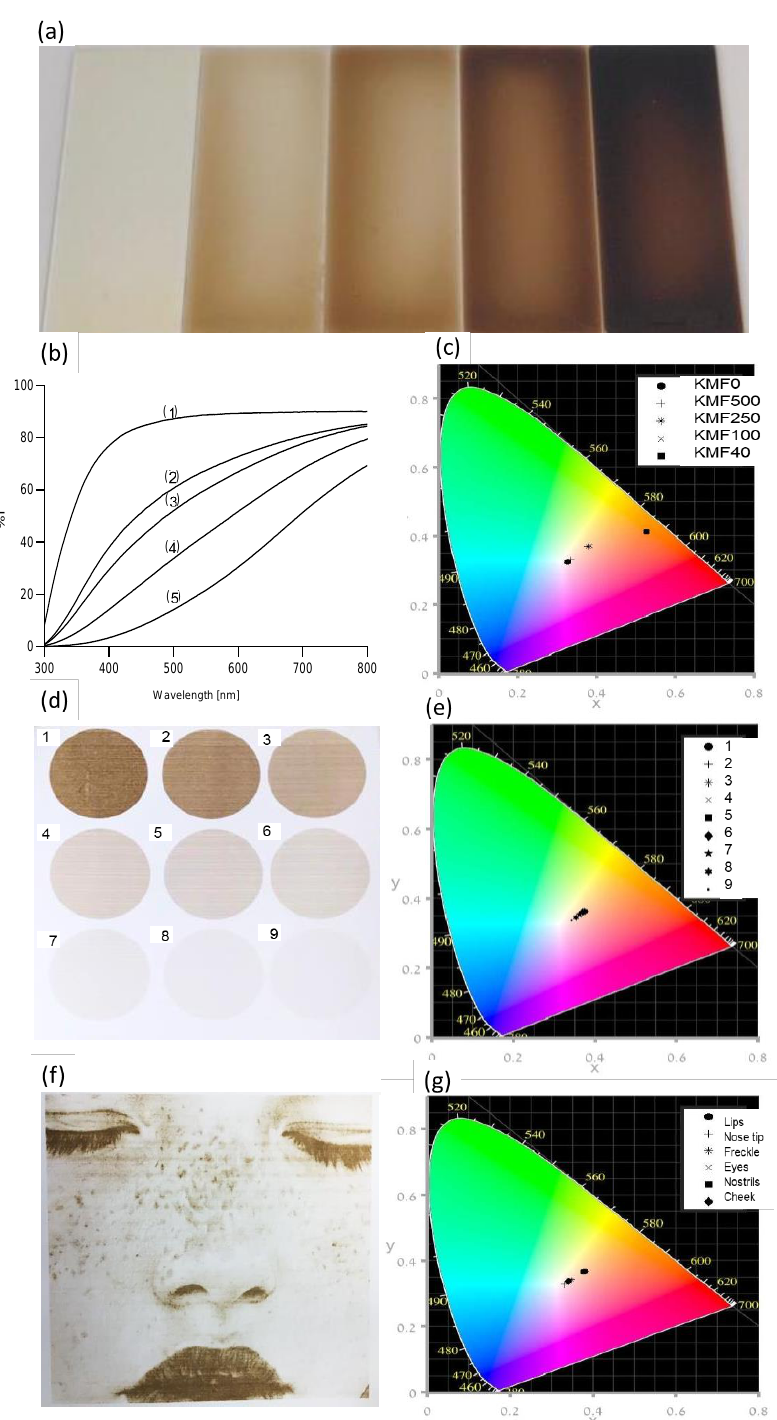
Figure 4. The optical properties of KMFs and keratin / melanin ink (KMI). ( a ) Keratin / melanin films with an increasing melanin concentration: KMF0, KMF500, KMF250, KMF100, and KMF40 (left to right). ( b ) UV-VIS transmission spectra of: (1) KMF0, (2) KMF500, (3) KMF250, (4) KMF100, and (5) KMF40. ( c ) The color changes for KMFs as a function of melanin content, as presented in the CIE 1931 color space. ( d ) Inkjet-printed skin color gradient (1–9 colors) from KMI. ( e ) The color changes of inkjet-printed skin color gradient, as presented in the CIE 1931 color space. ( f ) Inkjet-printed image of a face holding skin characteristics with KMI on Epson paper. ( g ) The color changes in di ff erent areas in the inkjet-printed face, as presented in the CIE 1931 color